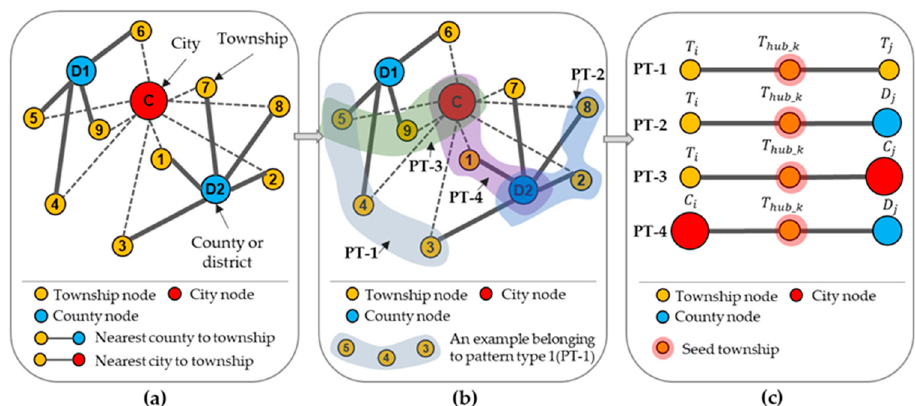
Figure 5. Four township hub level patterns with city and country nodes: ( a ) Form of proximity among townships, counties, and cities; ( b ) Township hub of PT1-PT4 marked by shadow paths; ( c ) Four patterns of focal township nodes as a hub of different townships, counties, or city nodes.